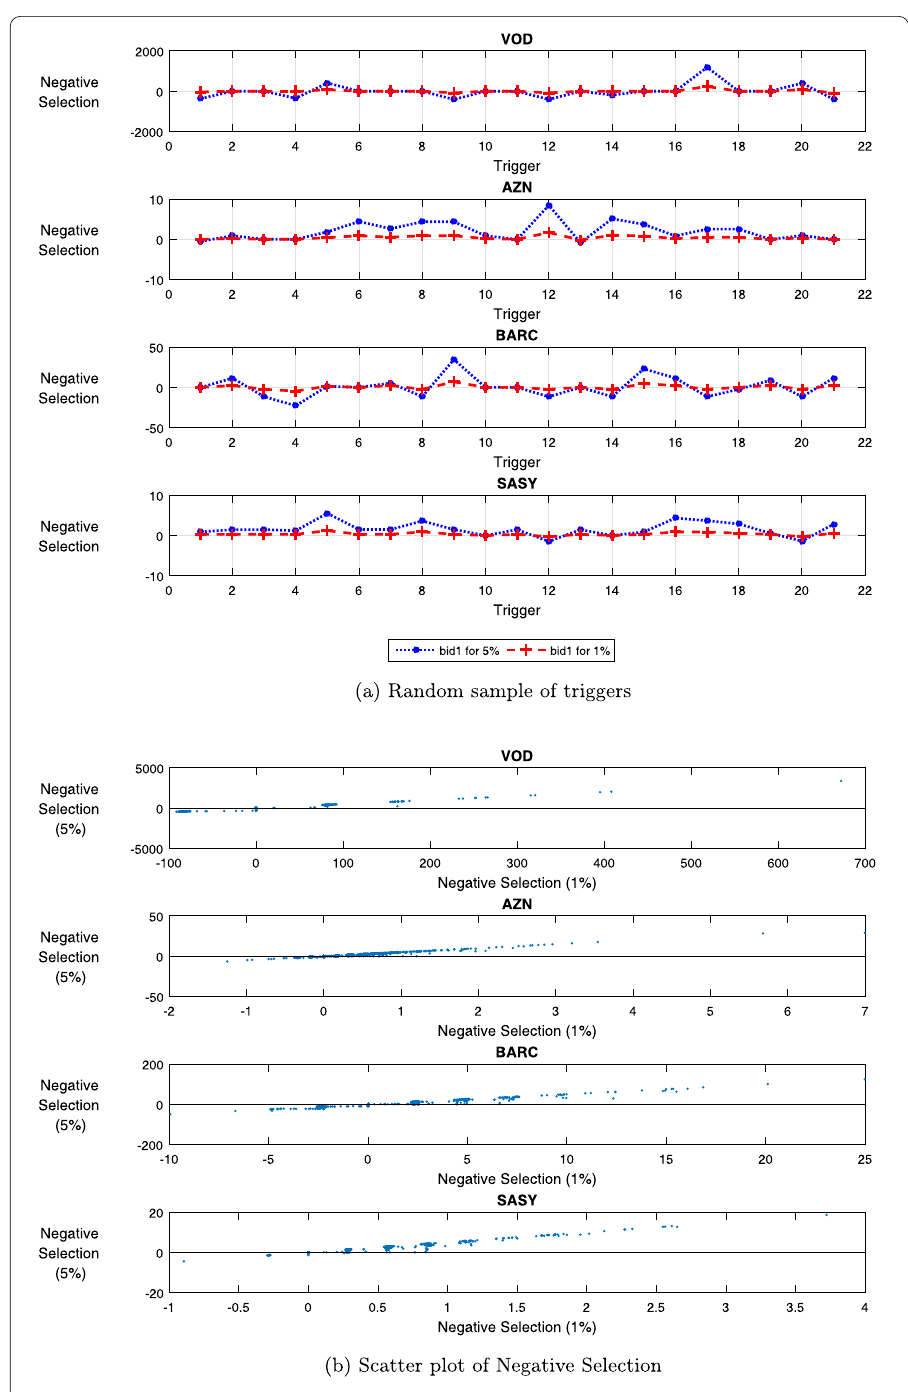
Figure 4 Comparison of Negative Selection by order size for bid/ask1